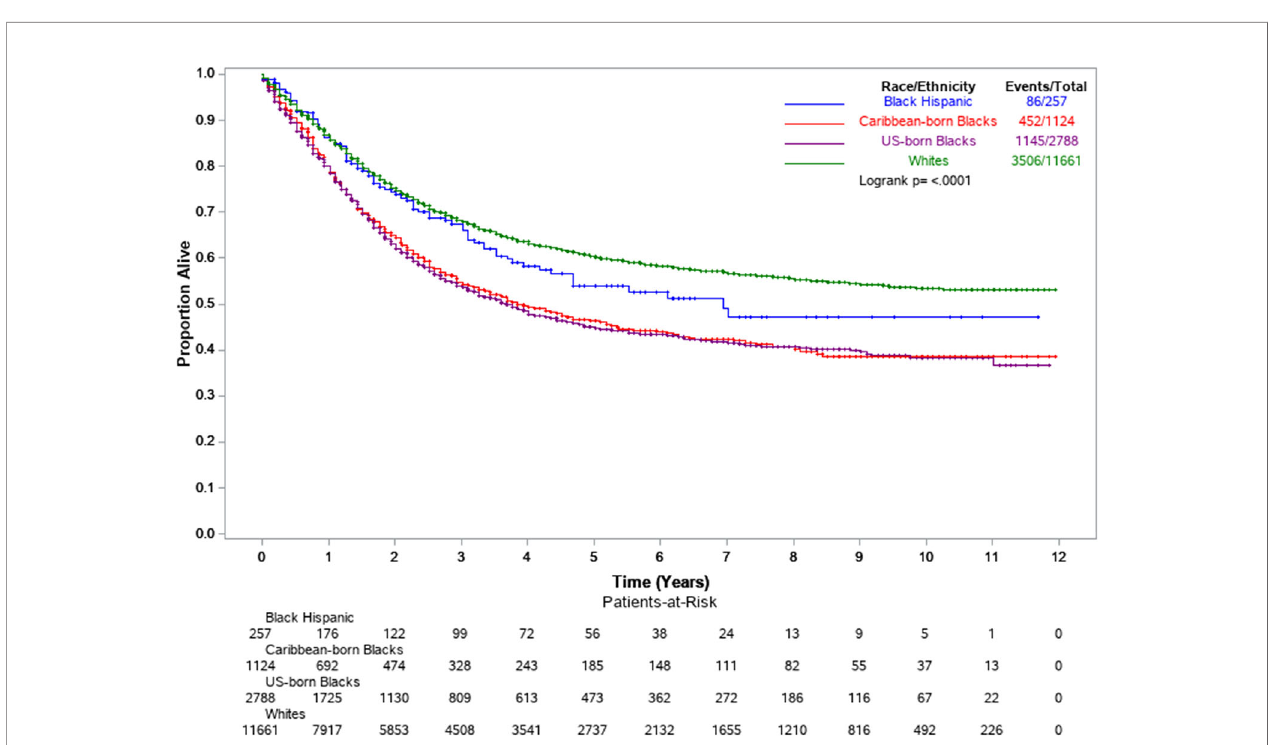
FIGURE 2 | Kaplan-Meier survival curves by select racial-ethnic groups. Florida and New York, 2005 –